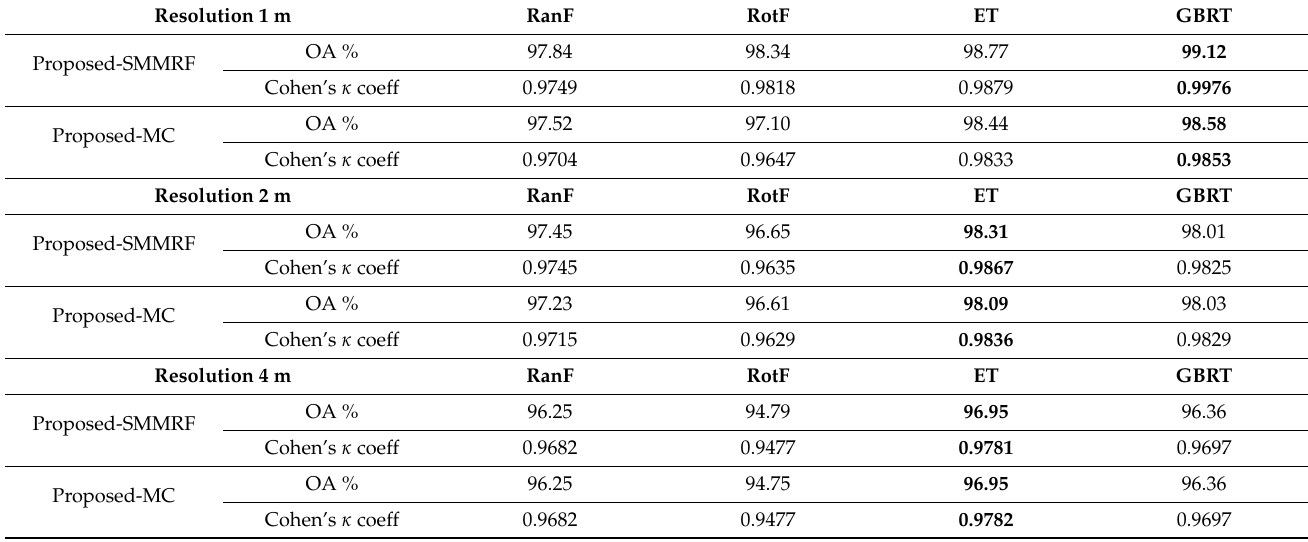
Table 3. “Alessandria” dataset: OA and Cohen’s κ with respect to the test set for the proposed methods employing SMMRF and MC, when combined with random forest (RanF), rotation forest (RotF), ExtraTrees (ET), and